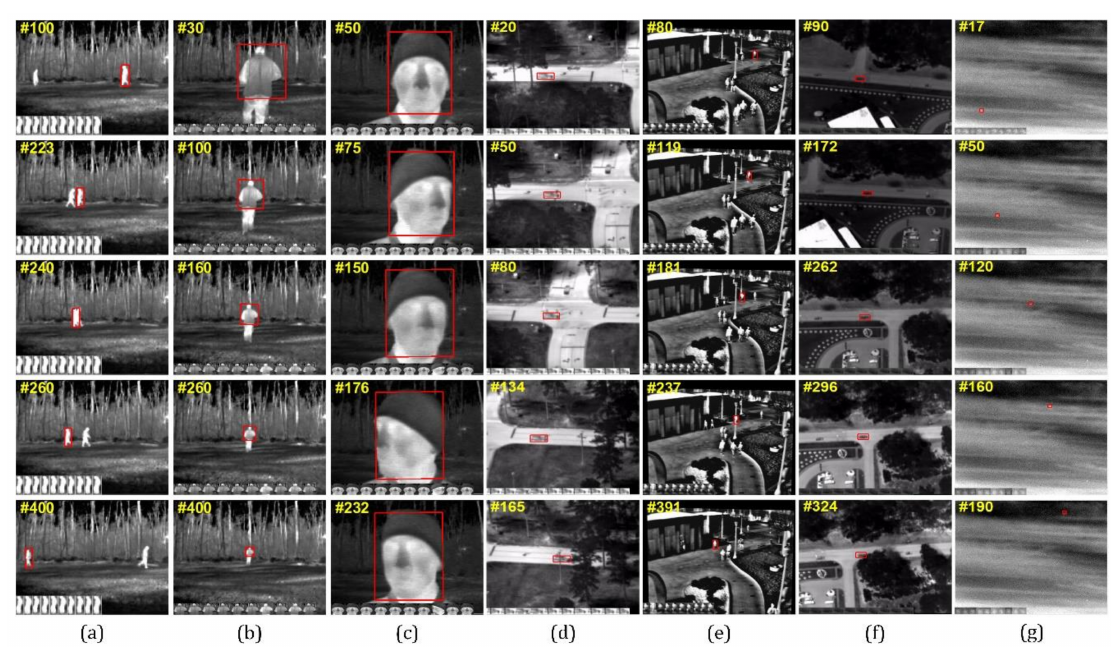
Figure 2. The tracking results of the proposed algorithm for each infrared sequence: ( a ) Seq.1; ( b ) Seq.2; ( c ) Seq.3; ( d ) Seq.4; ( e ) Seq.5; ( f ) Seq.6; and, ( g )